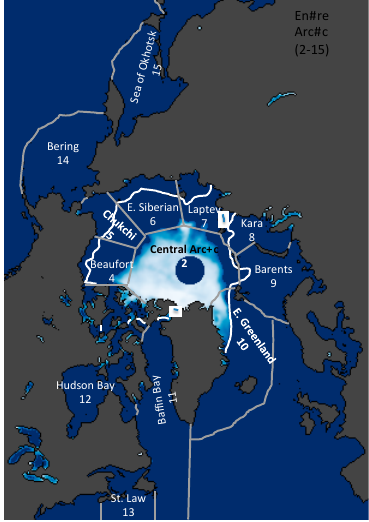
Figure 1. The record minimum September 2012 monthly average sea ice extent is illustrated by sea ice concentration contours from white to light blue contrasted against the 2003–2016 average September sea ice extent (solid white line).